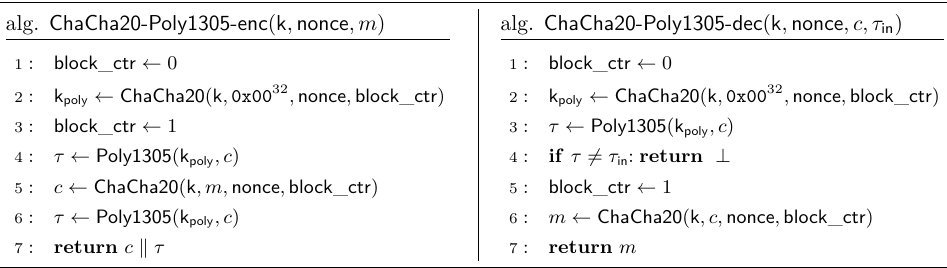
Figure 11: The nonce-based AE scheme ChaCha20 - Poly1305